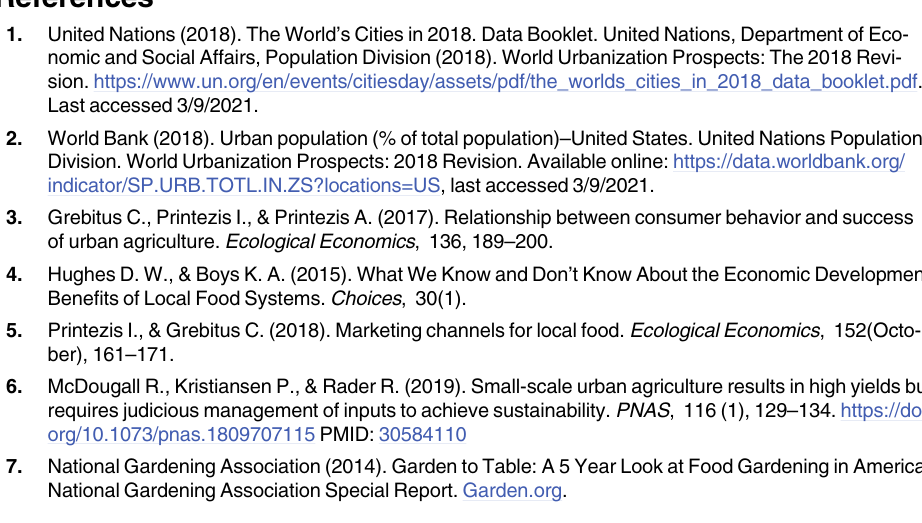
S1 Table. Socio-demographic characteristics of gardeners and non-gardeners. S2 Table. Knowledge and attitude regarding food growing. S3 Table. Personality